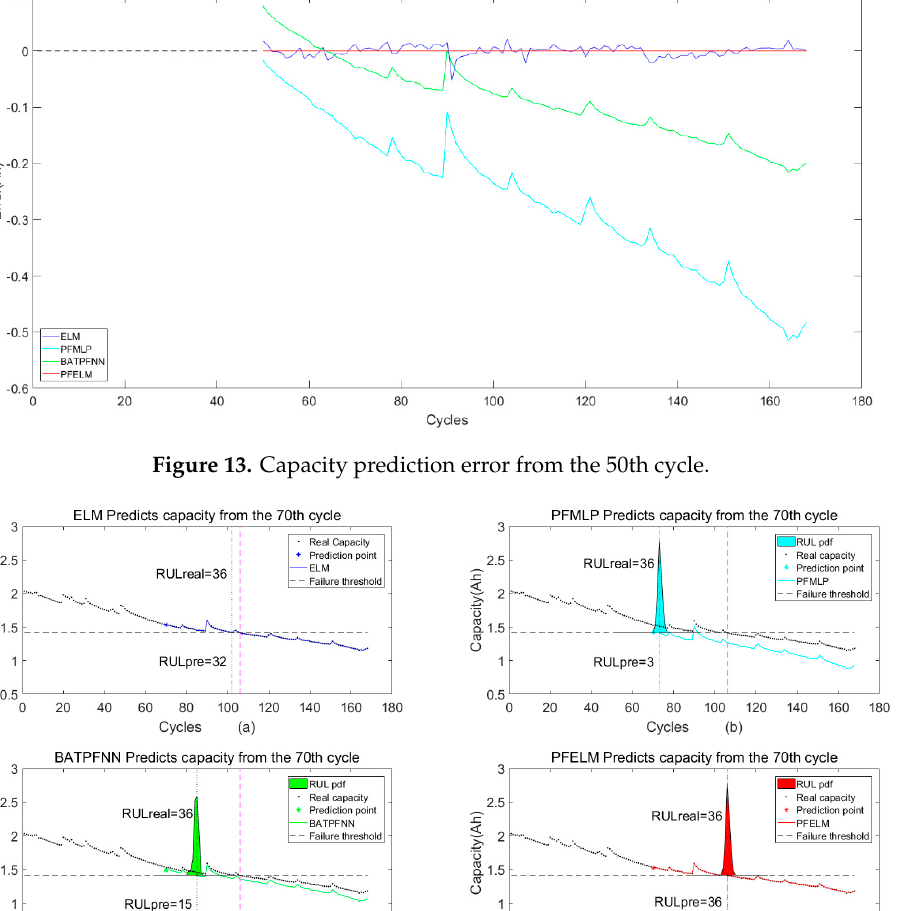
Figure 14. Predicting capacity from the first cycle by different algorithms: ( a ) ELM ; ( b ) PFMLP; ( c ) BATPFNN; ( d ) PFELM.